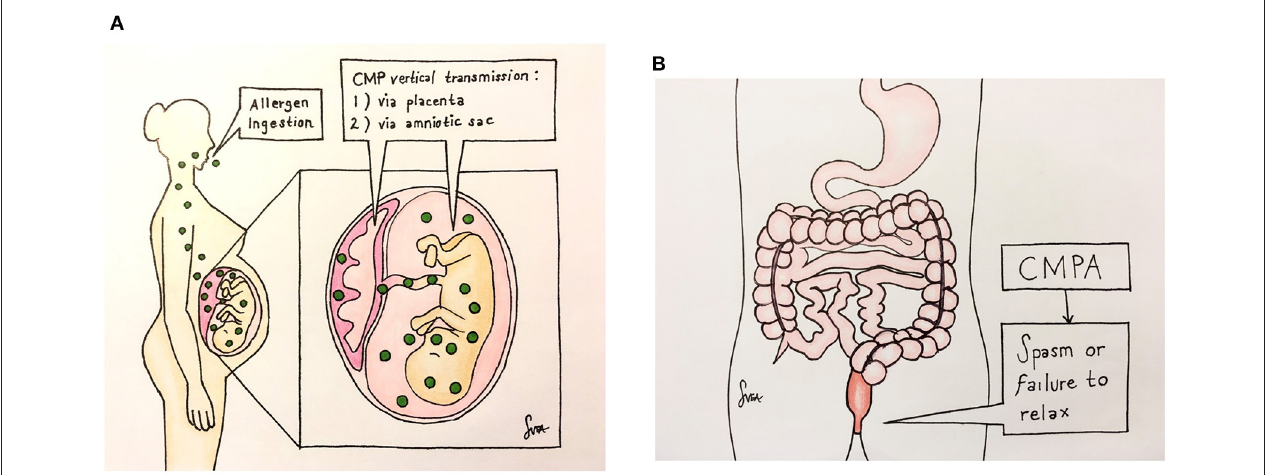
FIGURE 2 | Illustrates how the maternal CMP exposure leads to the development of neonatal constipation. The CMP allergen is vertically transmitted during pregnancy from a mother to a fetus via the placenta and amniotic fluid to cause CMPA (A) . When the CMPA involves the colon, constipation results (B) . There, the allergy causes neuromuscular dysfunction by a yet-unknown non-IgE mechanism, leading to anal spasm or failure of the anal sphincter to relax, resulting in a functional obstruction.